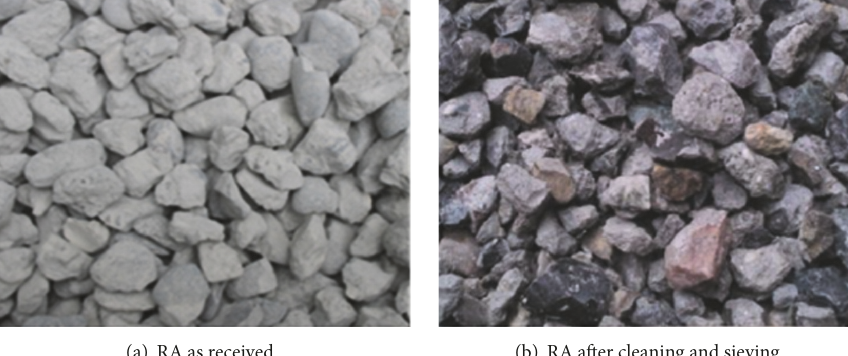
Figure 2: RA before and after washing.